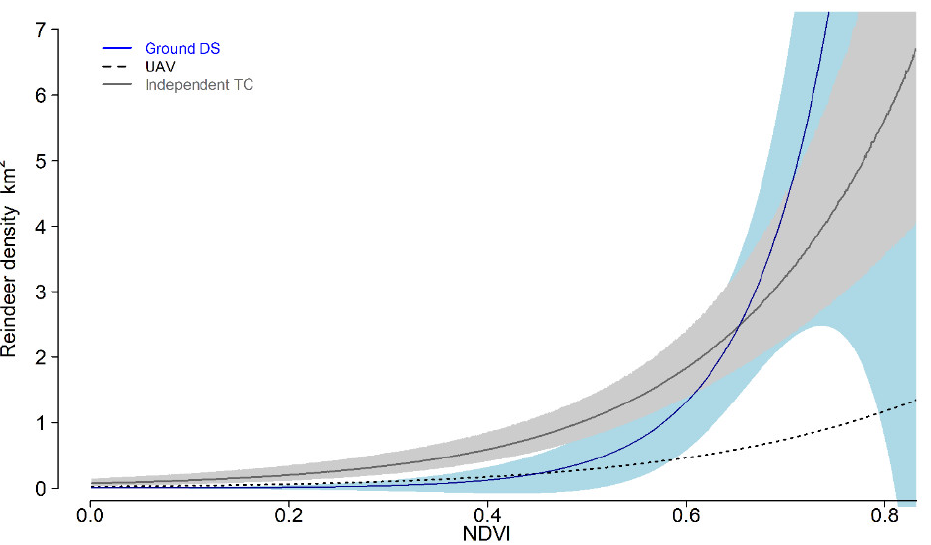
Figure 4. Predicted density of Svalbard reindeer (number of animals per km 2 ) based on data from the three different survey methods (ground DS, drone, and independent total counts) as a function of maximum normalised difference vegetation index (maxNDVI, i.e., proxy of biomass production). The independent total counts model from the neighboring valley estimated similar abundances in the helicopter surveyed area (1515 ± 101, Table 1) as the helicopter survey ( n = 1559) in Sassendalen. The UAV density model estimated the lowest abundances with the largest uncertainties (i.e., CVs range: 0.11–0.29), underestimating abundance by 70–75% compared to ground DS and UAV at the different sampling scales. The ground DS and the independent ground TC estimated similar abundance at all sampling scales. The independent ground TC gave the most precise estimates (CVs range: 0.07–0.24), while